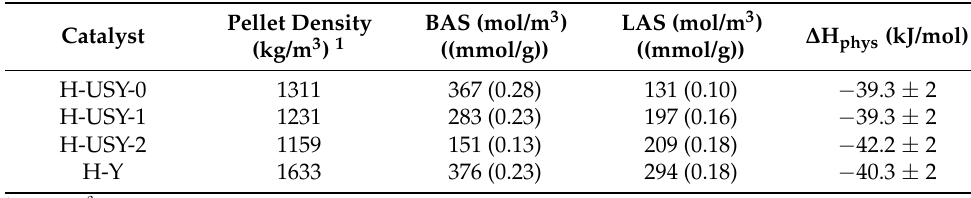
Table 4. Pellet density, number of acid sites according to FT-IR study of adsorbed pyridine and enthalpy of physisorption by